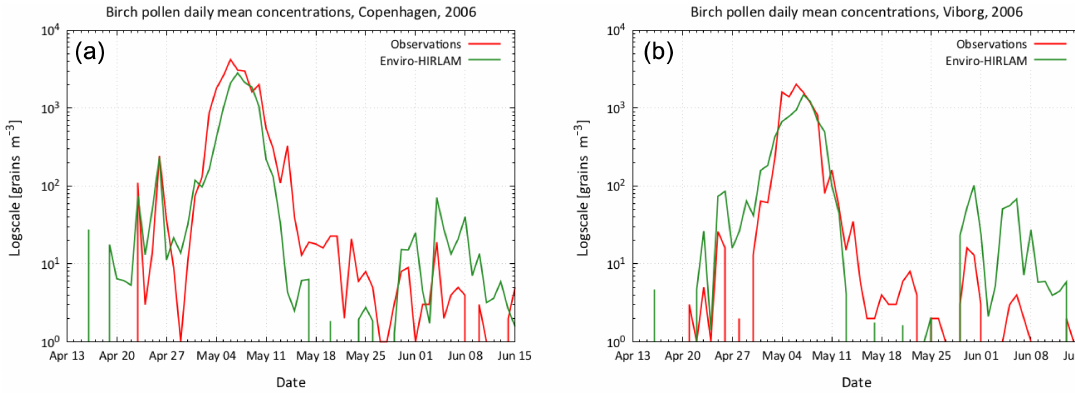
Figure 13. Birch pollen concentrations observed (red) versus modelled (green) at Danish sites: Copenhagen (a) and Viborg (b)